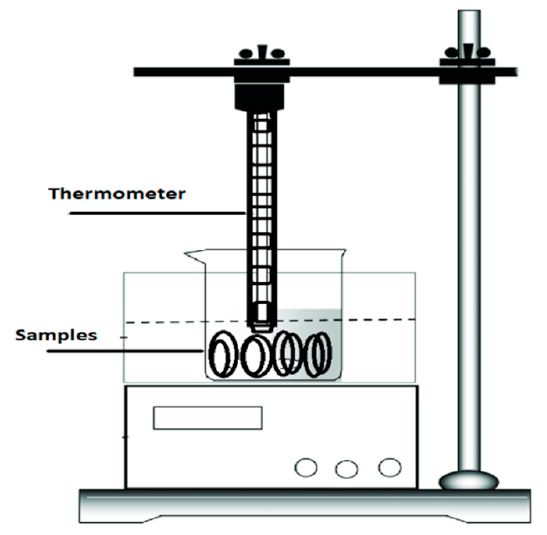
Figure 1. Hydrothermal aging setup.